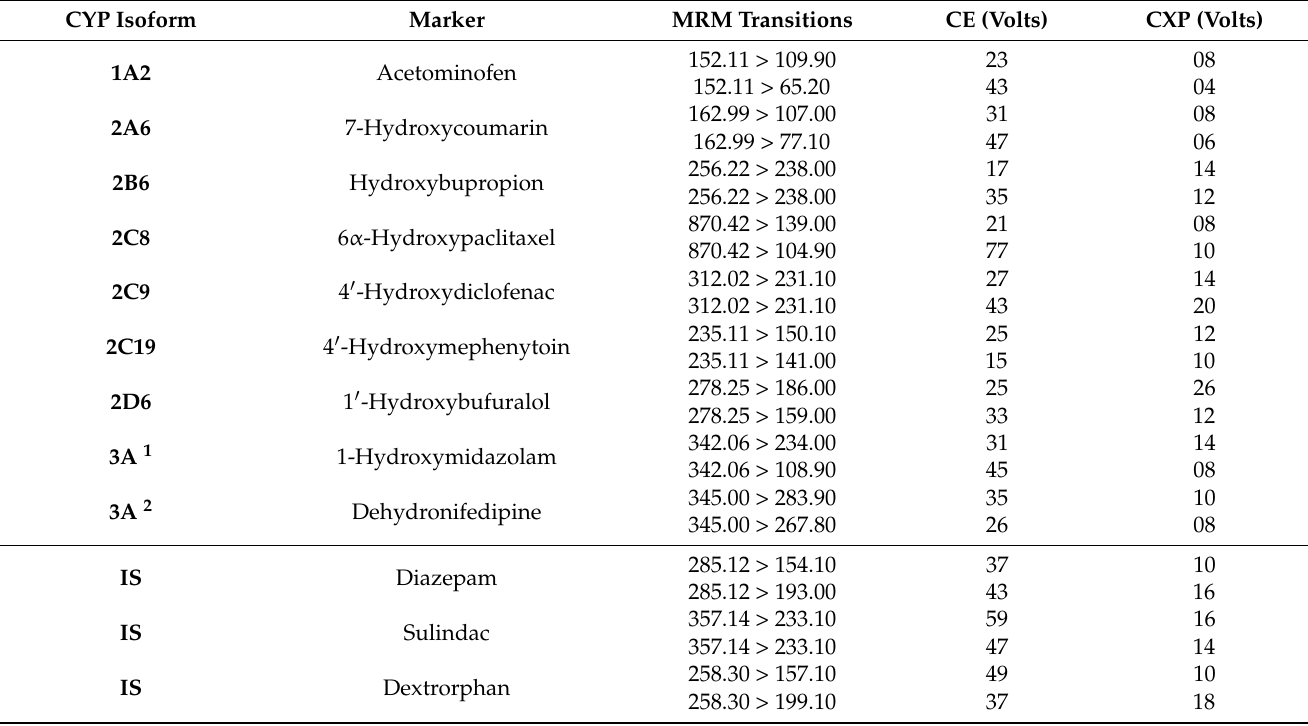
Table 2. LC-MS/MS conditions.